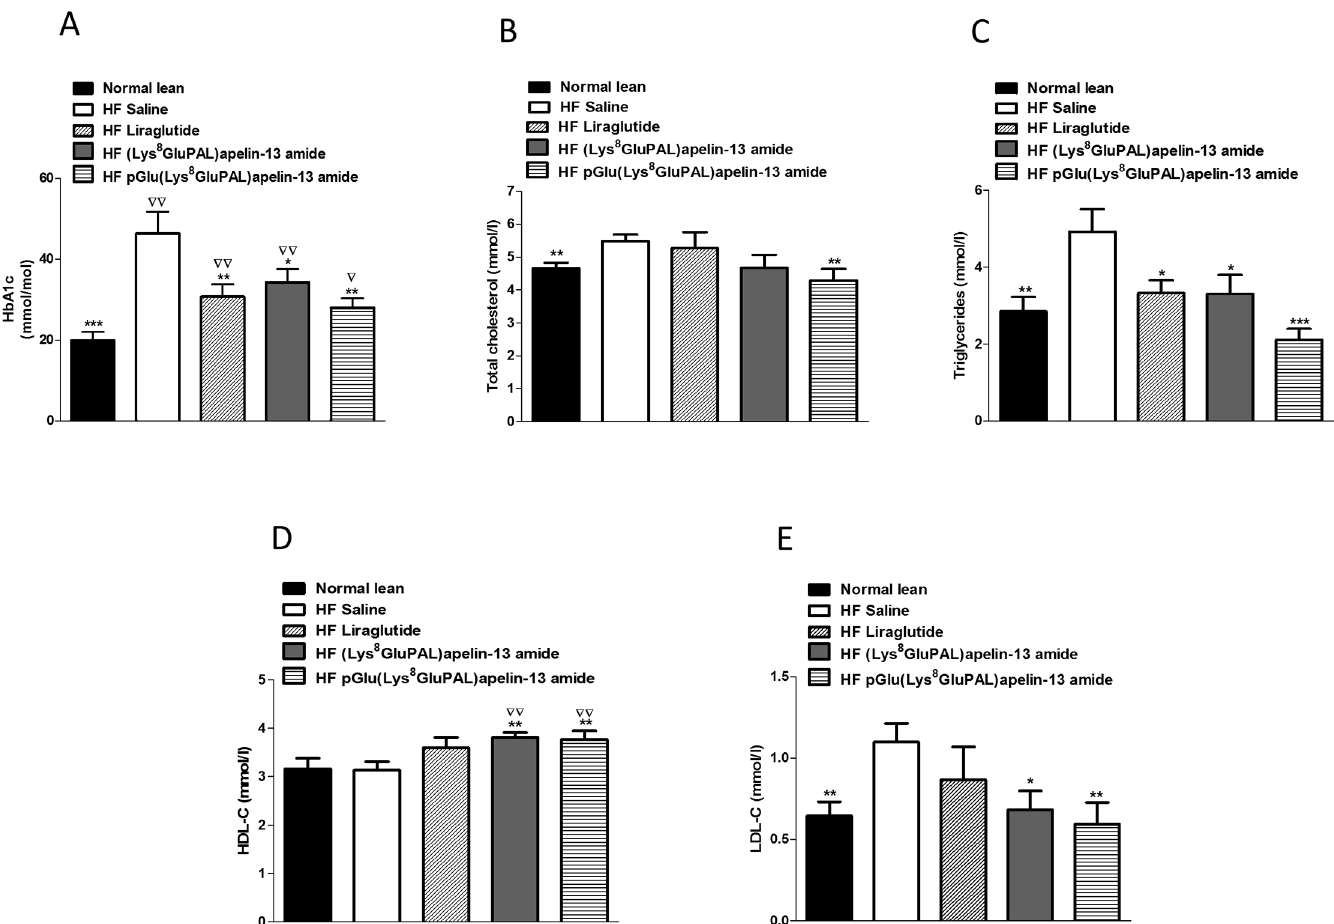
Fig 4. Effect of once daily i.p. administration of liraglutide, (Lys 8 GluPAL)apelin-13 amide or pGlu(Lys 8 GluPAL)apelin-13 amide (each at 25 nmol/kg bw). After 40 days HbA 1c (A), plasma total cholesterol (B), triglycerides (C), HDL cholesterol (D) and LDL cholesterol (E), after 40 days of treatment were measured in high-fat fed mice. Values represent the mean ± S.E.M. (n = 8) where (cid:3) p < 0.05, (cid:3)(cid:3) p < 0.01 and (cid:3)(cid:3)(cid:3) p < 0.001 is compared to high-fat fed saline treated mice, 5 p < 0.05 and 55 p < 0.01 is compared to normal